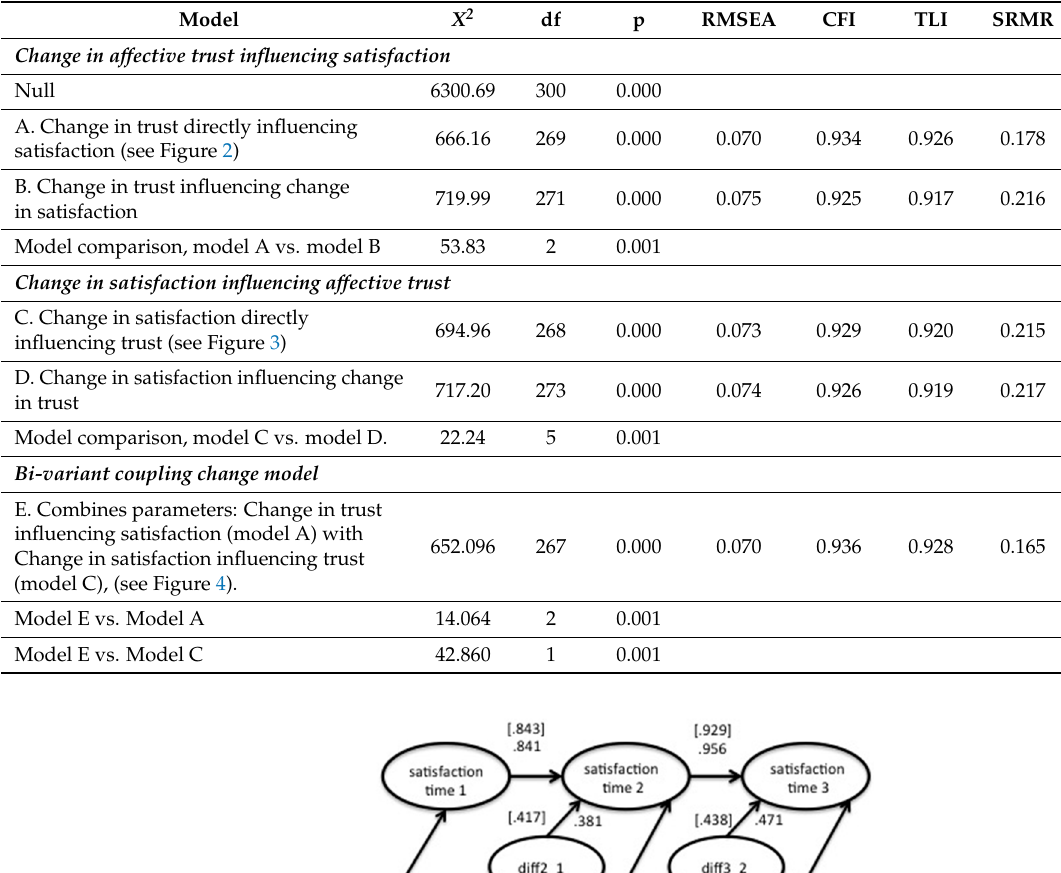
Table 3. Examining the relationship between changes in affective trust and changes in satisfaction with one’s team.